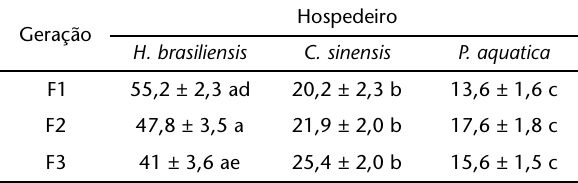
Tabela VII. Fecundidade (número de ovos/fêmea) e erro padrão da média nas gerações F1, F2 e F3 de E . banksi sobre H . brasiliensis